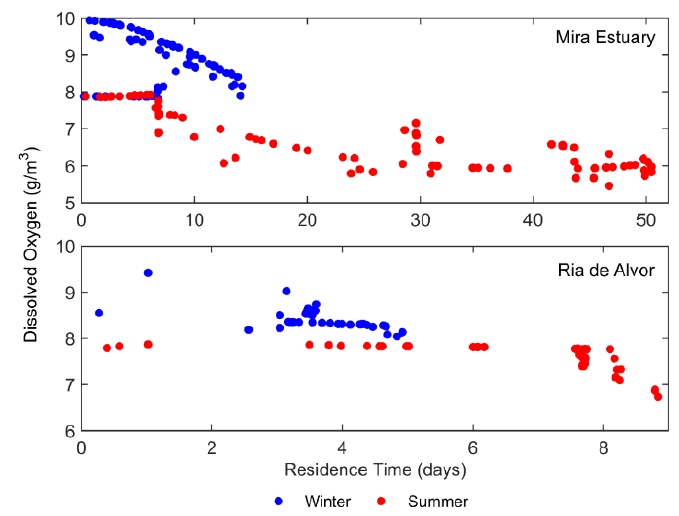
Figure 11. Relation between dissolved oxygen concentration (g/m 3 ) and the residence time throughout Mira Estuary and Ria de Alvor, for winter (blue dots) and summer (red dots).